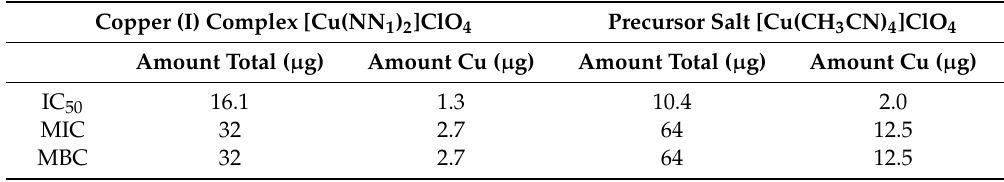
Table 2. Comparative table of amount cooper in MIC, MBC and IC 50 on F. psychrophilum of the